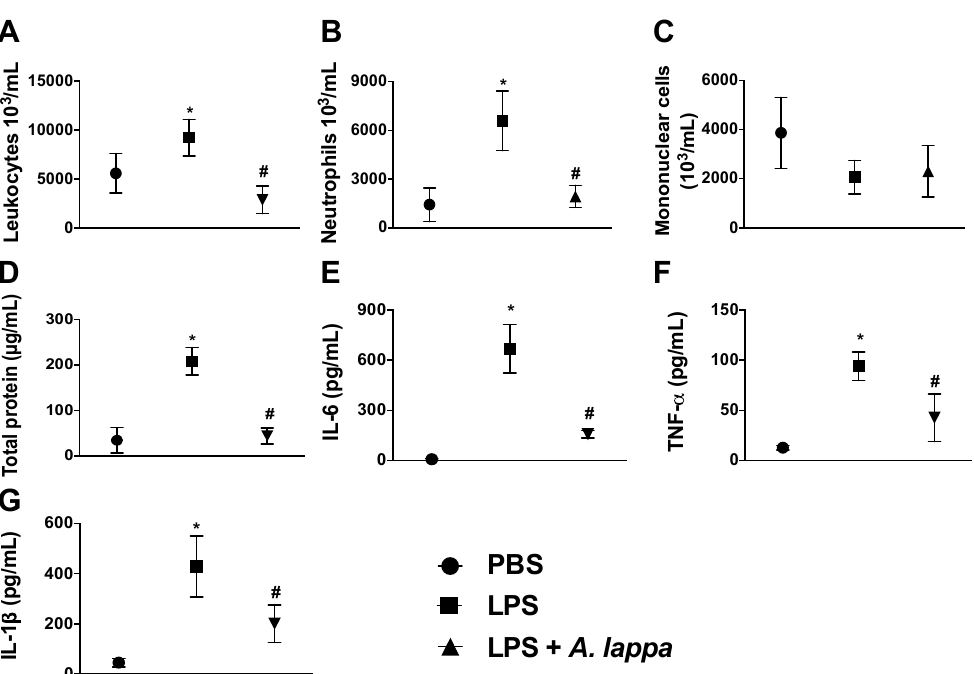
Figure 2. A. lappa extract suppresses inflammation in lipopolysaccharide (LPS)-inflamed air pouches. After 1 h of injection of phosphate-buffered saline (PBS) (PBS/1 mL/pouch) or LPS (1 μ g/mL/1 mL/pouch) into air pouches, mice were injected with Alhe (300 mg/kg/1 mL/pouch) or PBS (PBS/1 mL/pouch). Total and differential leukocyte numbers were determined in the lavage fluid, after 4 h. ( A ) Total leukocytes, ( B ) neutrophils, ( C ) mononuclear cell counts, and ( D ) total protein quantification. ( E ) IL-6, ( F ) TNF- α , and ( G ) IL-1 β were quantified by ELISA. The experiment was conducted twice using five mice per group (n = 5), and error bars denote mean ± SEM. * PBS (control) versus LPS; # LPS versus LPS + A. lappa . Differences were considered significant if p < 0.05 according to ANOVA with Tukey’s post-test.